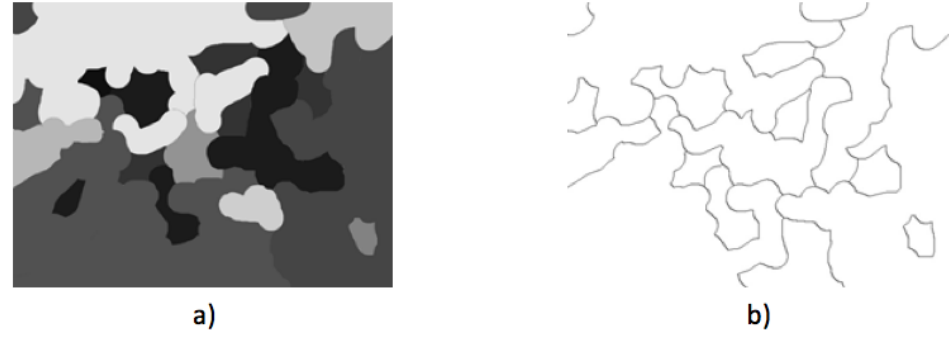
Figure 13. Example of watershed segmentation: ( a ) synthetic test image; and ( b ) the resulting segmented image.